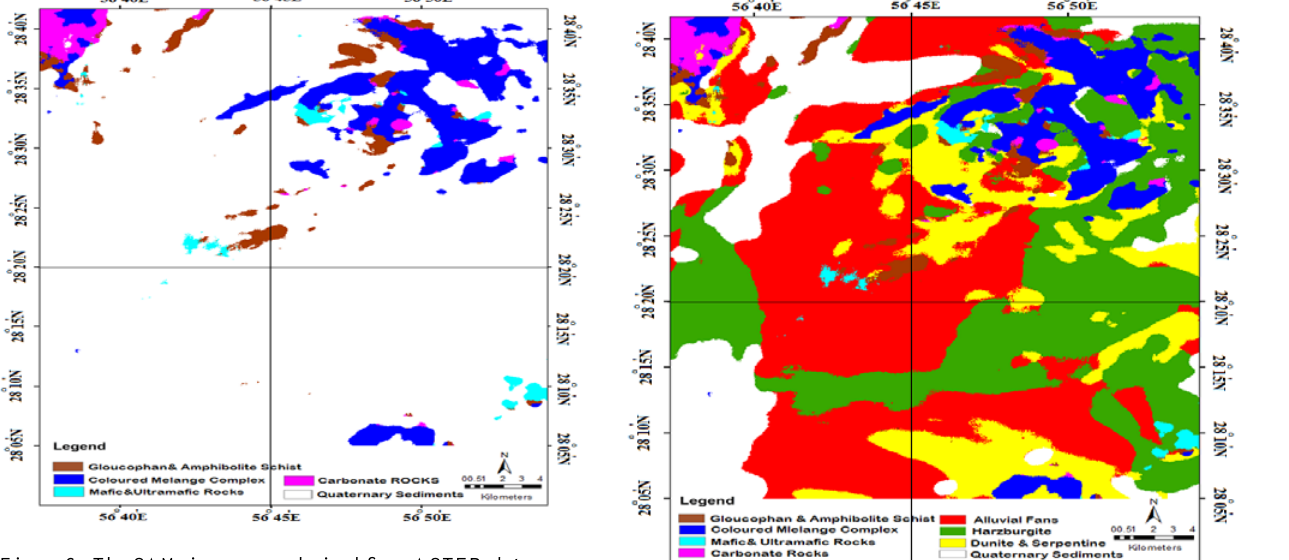
Figure 6. The SAM image map derived from ASTER data.